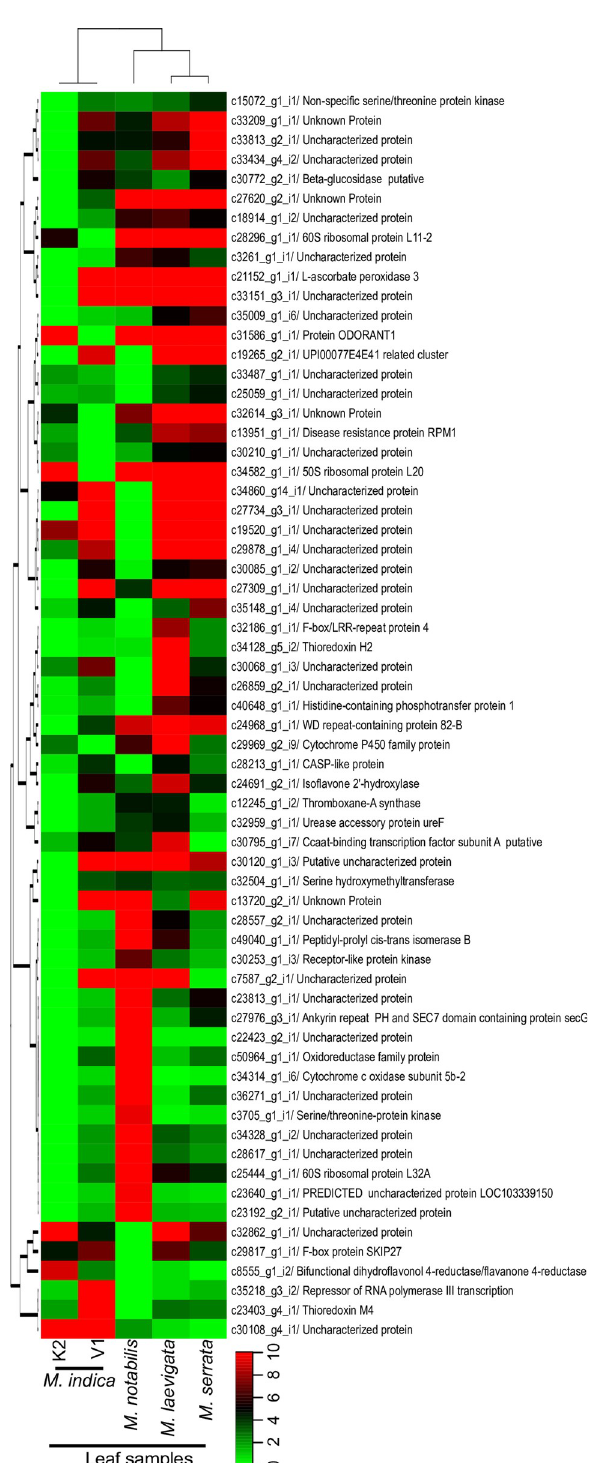
Fig 2. Heatmap showing the relative expression pattern exhibited by the > = 10 fold change showing differentially expressed genes in five leaves samples of three genotypes and two cultivars from a fourth species. Mean normalized FPKM values obtained were used to plot the heatmap after applying Ward’s correction and Manhattan clustering.